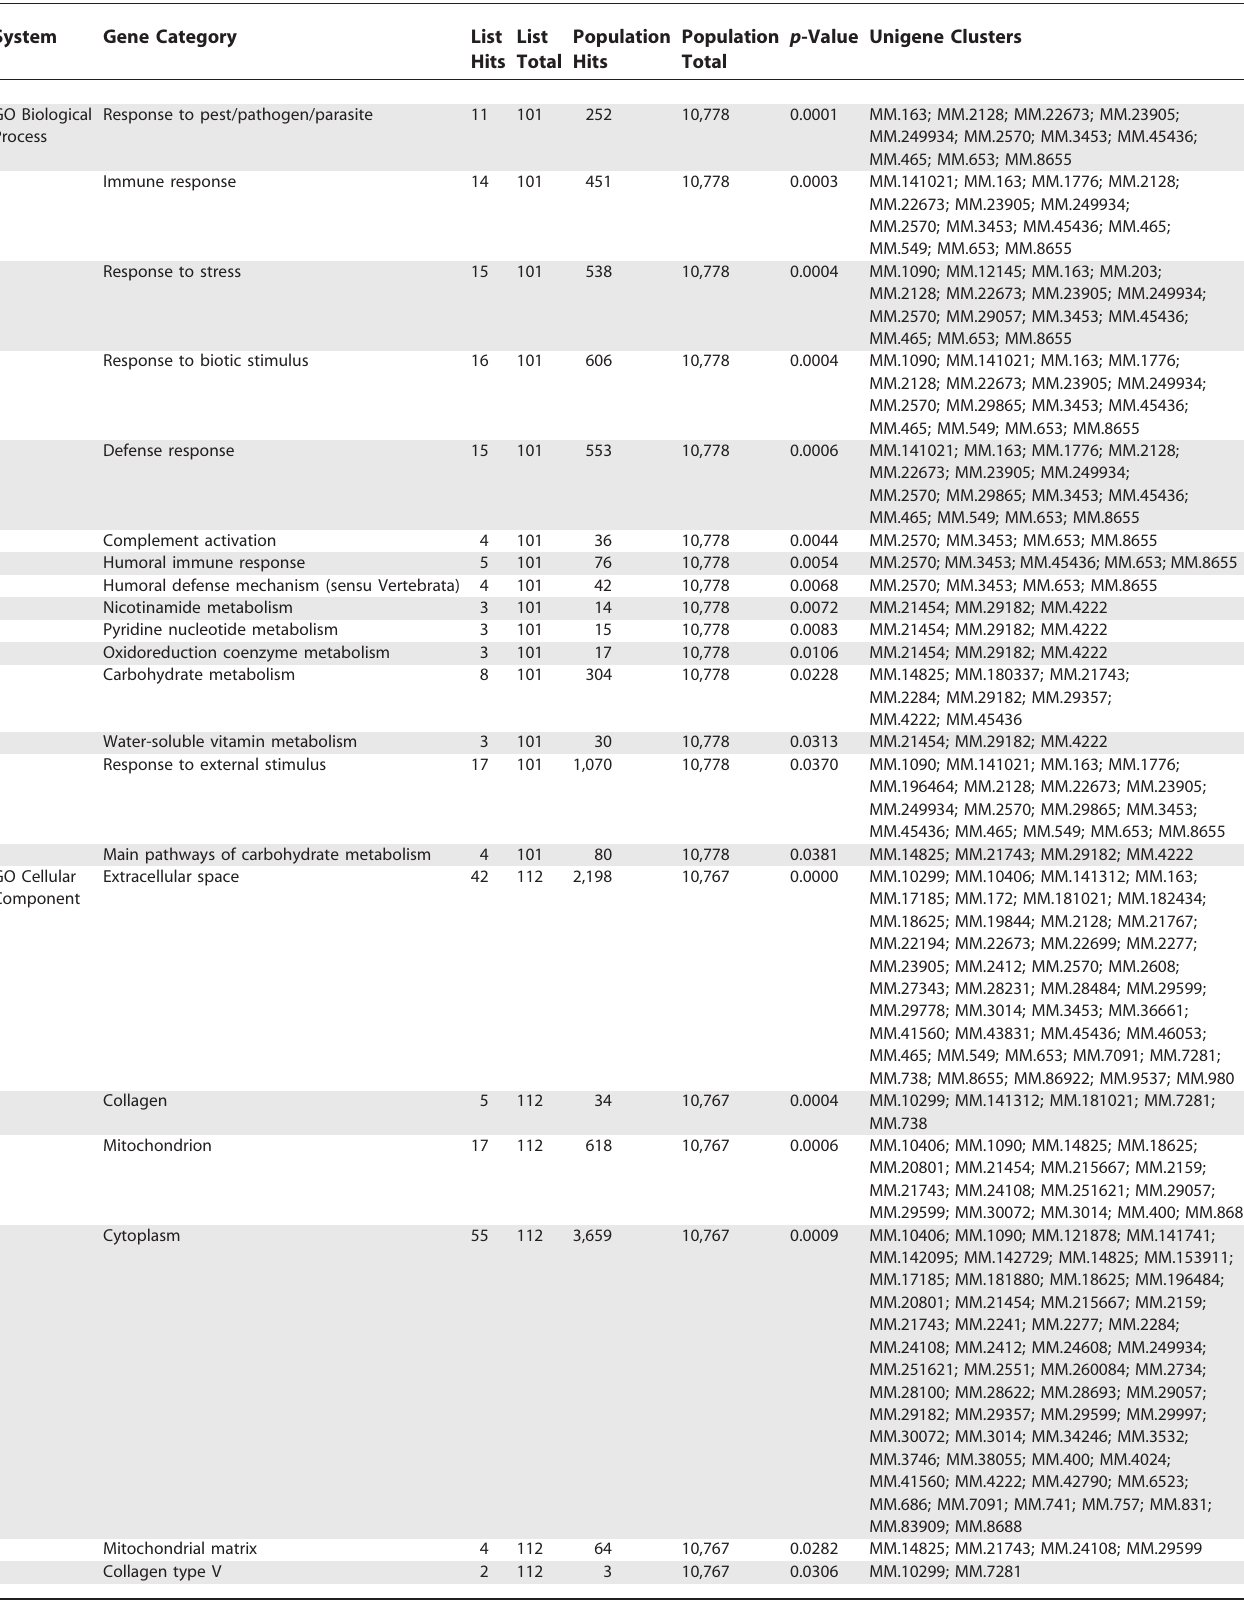
Table 5. Pathway Analysis for Upregulated Genes in Lymphedema versus Normal Control (SAM, FDR ,